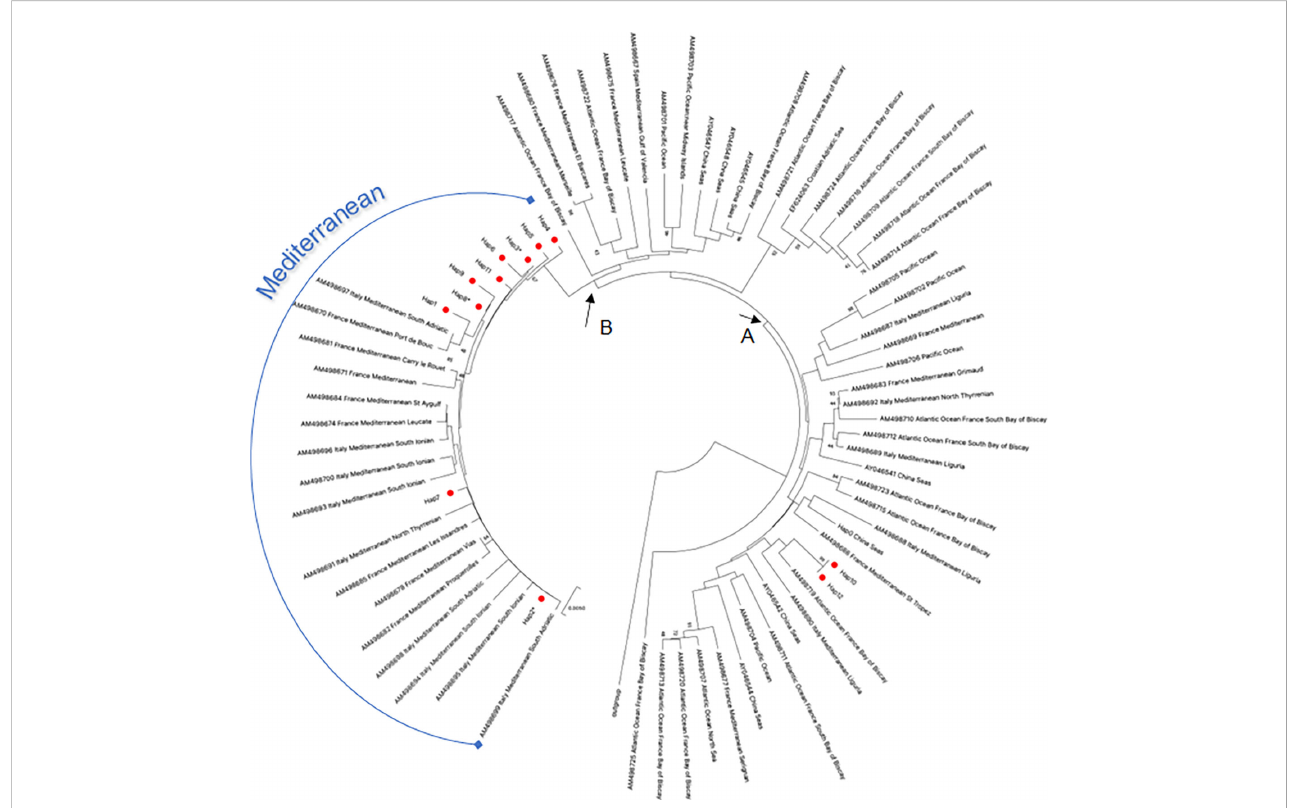
FIGURE 3 NJ tree inferred from S. coeruleoalba D- loop sequences. Evolutionary analyses were conducted in MEGA X (Kumar et al., 2020). The optimal tree, with the sum of branch length = 1.27736443 is shown. The tree is drawn to scale, with branch lengths in the same units as those of the evolutionary distances used to infer the phylogenetic tree. The evolutionary distances were computed using the p-distance method (Nei and Kumar, 2000) and are in the units of the number of base differences per site. This analysis involved 281 nucleotide sequences. All ambiguous positions were removed for each sequence pair (pairwise deletion option). There was a total of 638 positions in the fi nal dataset. The red circles indicated the haplotypes of S. coeruleoalba identi fi ed in the study area. An asterisk indicates haplotypes in the Gulf of Taranto also identi fi ed in other geographic areas (Supplementary Table 2). (A, B) nodes indicate the distribution of the striped dolphin haplotypes from the study area as discussed in the